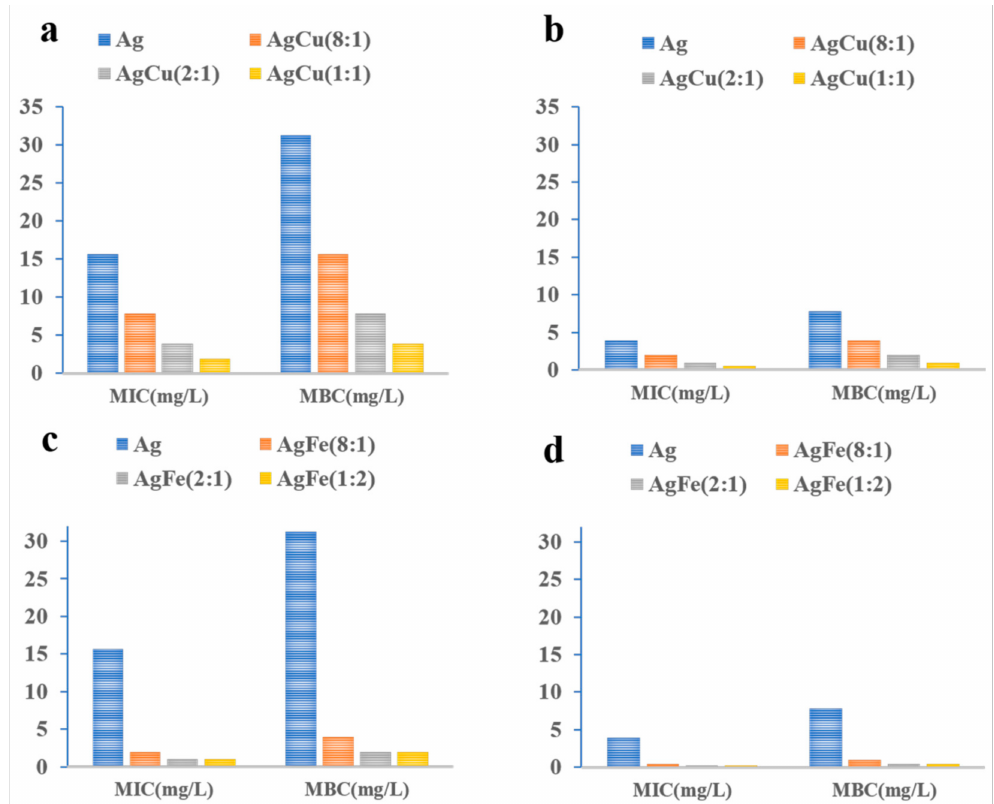
Figure 5. MIC/MBC comparison of various Ag/M ratios against ( a , c ) S. aureus (ATCC 6538) and ( b , d ) E. coli (ATCC